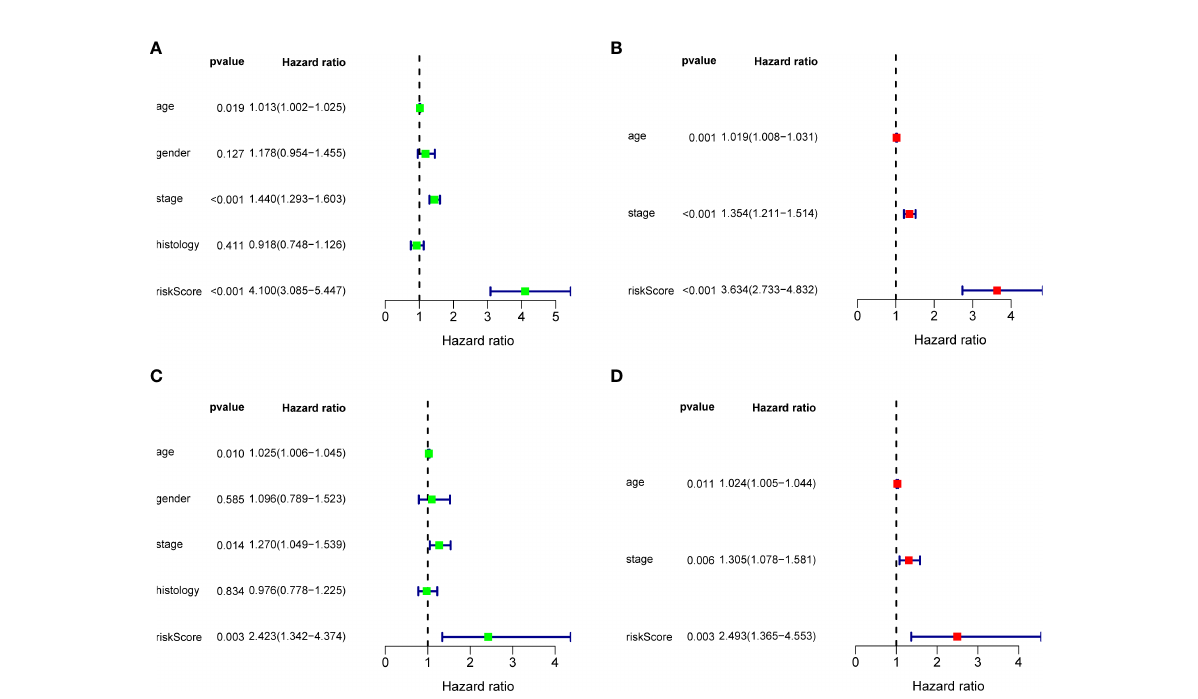
FIGURE 3 Cox regression analysis for BRGPs signature. (A, B) Forest plot of univariate (A) and multivariate (B) Cox regression analyses for the prognosis of NSCLC patients in the training cohort. (C, D) Forest plot of univariate (C) and multivariate (D) Cox regression analysis for the prognosis of NSCLC patients in the validation cohort. BRGPs, B cell-related gene pairs; NSCLC, non-small cell lung